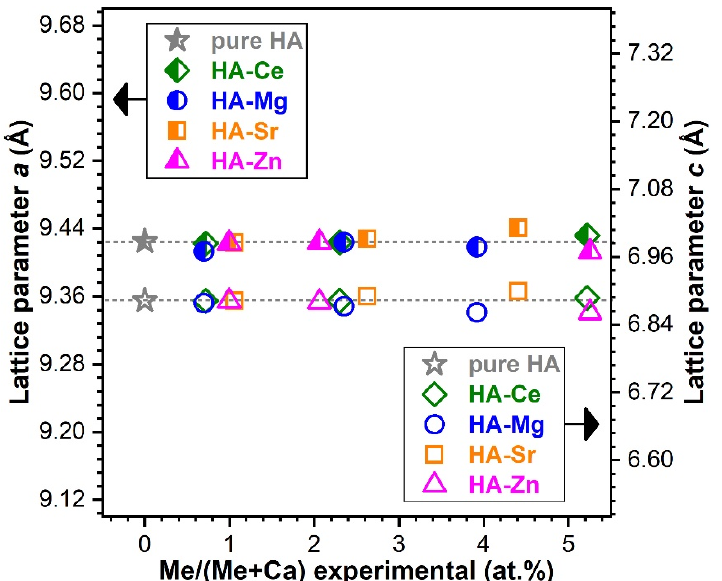
Figure 9. Variation of the a and c lattice parameters as a function of the cation substituent concentration. The errors (bars) of the lattice parameters (as determined by fitting) were not figured since they were too small to be well-visualised.